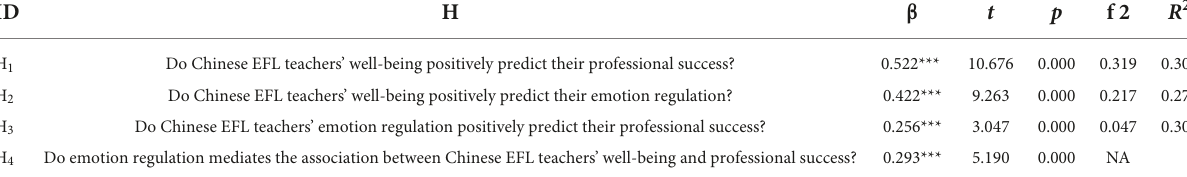
TABLE 6 The results of